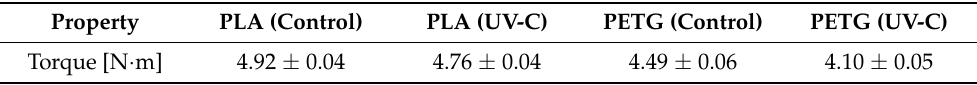
Table 6. Untightening torque test